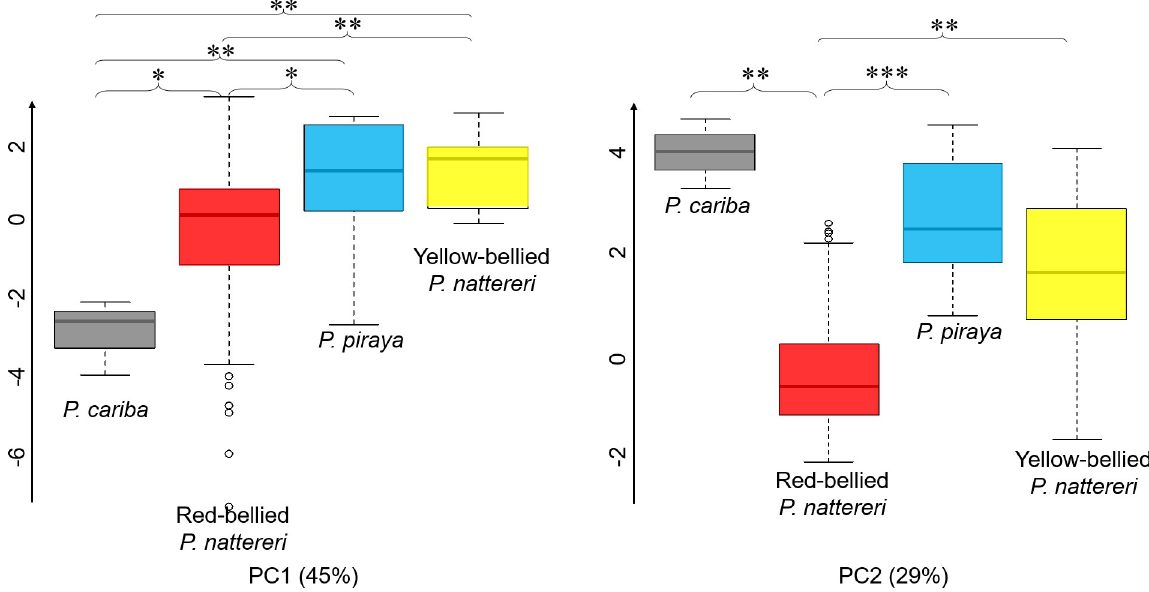
Fig 5. Comparison of the scores from principal component analysis (PCA) in the genus Pygocentrus . Boxes represent the median ± interquartile range (IQR) and lines represent Q1–1.5 IQR and Q3 + 1.5 IQR. � = P < .05; �� = P < .01; ��� = P < .001; Kruskal-Wallis +